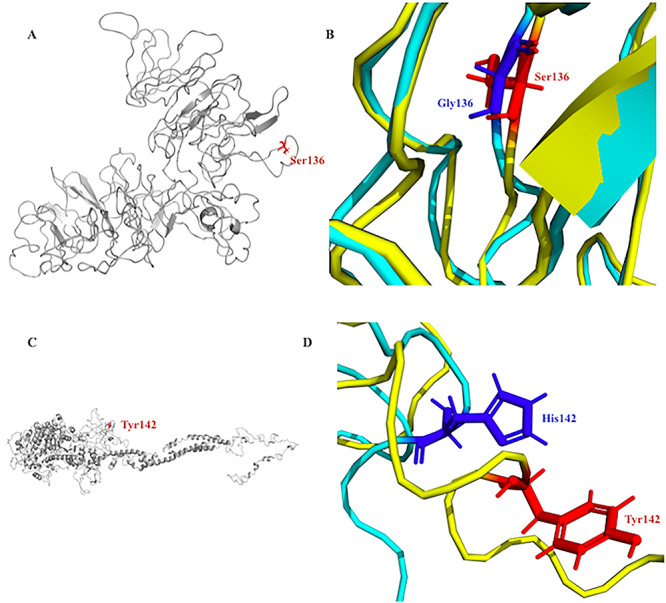
Molecular modeling scheme of the COL9A p.Gly136Ser and MYO3A p.His142Tyr mutants. (A) COL9A protein with mutated residue (SER136) colored red. The non-conservative substitution of uncharged non-polar GLY136 amino acid with uncharged polar amino acid SER136 renders the protein structure inflexible and may impact the binding interactions, stability and conformation of the protein. (B) Enlargement of the COL9A mutation site comparing the configuration of the wild type (colored cyan) and mutant (colored yellow) protein and illustrating the flexibility of the structures. (C) MYO3A protein product showing the mutated residue (TYR142) colored red. The substitution of the positively charged and hydrophilic amino acid HIS142 with the uncharged polar and hydrophobic amino acid TRP142 could impact the binding interactions and the stability of structure and conformation of the protein. (D) Enlargement of the MYO3A mutation site comparing the configuration of the wild type (colored cyan) and mutant (colored yellow) protein and illustrating the flexibility of the structures.